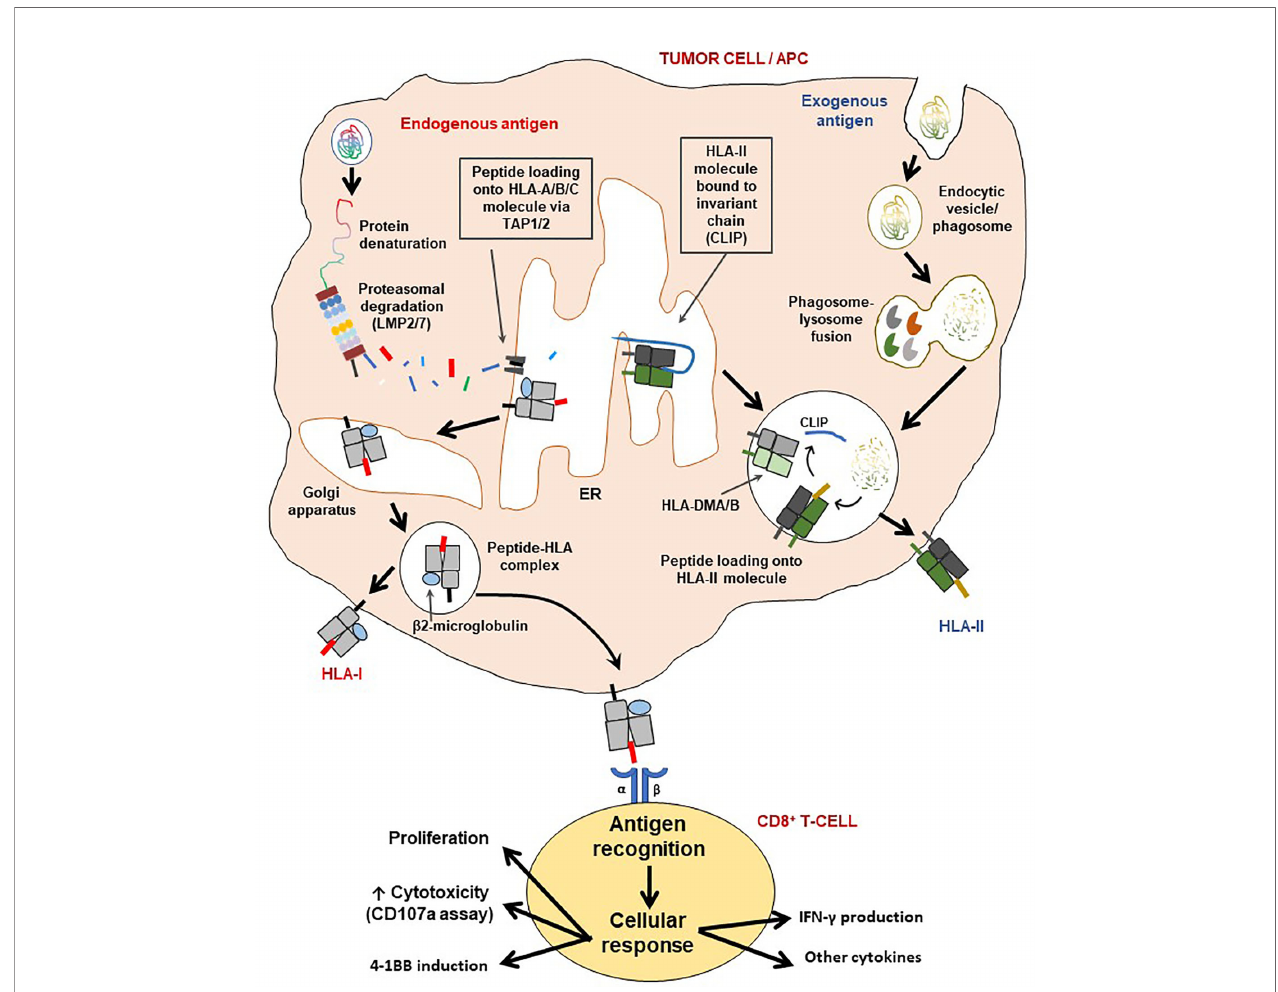
FIGURE 3 | Schematic representation of the HLA class I and II pathways and T-cell activation. The HLA class I pathway is also known as the intrinsic pathway as it processes and presents endogenous antigens while antigens derived from the extracellular environment are processed and presented via the HLA class II (extrinsic) pathway. LMP2/7 are immunoproteasome subunits necessary for generating short epitopes (7-11 amino acids along), which are then loaded on the HLA class I molecule for presentation to CD8 + T-cells. The b 2-microglobulin ( b 2M) is critical for the assembly and stable expression of HLA class I-peptide complexes on the cell surface. On the other hand, HLA class II molecules fi rst exist with the class II-associated invariant chain (CLIP) for stability, which is then removed with assistance from the HLA-DMA/B complex, for loading of CD4 + T-cell epitopes generated via lysosomal degradation. Processed antigens are then presented by either HLA-II (extrinsic pathway) or HLA-I (intrinsic pathway), to T-cells to initiate an immune synapse followed by activation of the latter. Indeed, as a result of cognate antigen recognition, T-cells may produce one or a combination of effects: i) cellular proliferation (also involves IL-2), ii) increase in cytotoxicity (may be measured by surface CD107a induction assay), iii) induction of 4-1BB expression and/or iv) production of cytokines, such as IFN- g , TNF- a , IL-2,